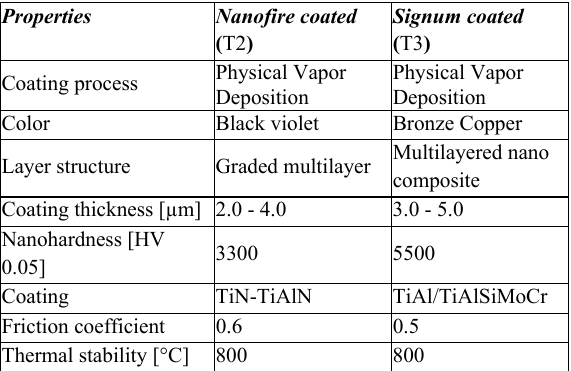
Table 1. Coating specifications of coated carbide cutting